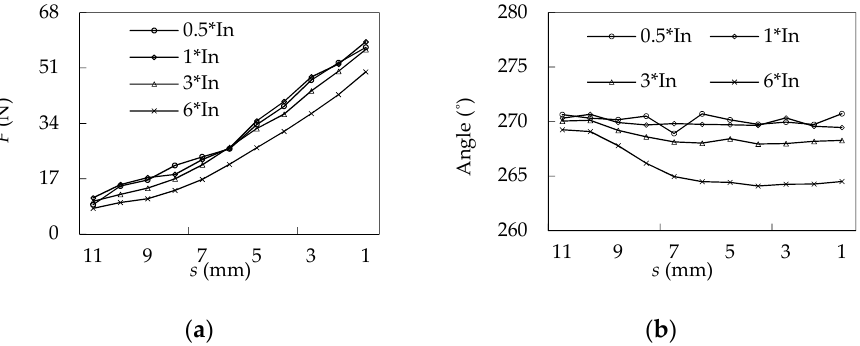
Figure 10. The effect of the current on EF (in the non-centerline of the PM slot, L = 0.05 mm): ( a ) the amplitude curve; ( b ) the phase curve.